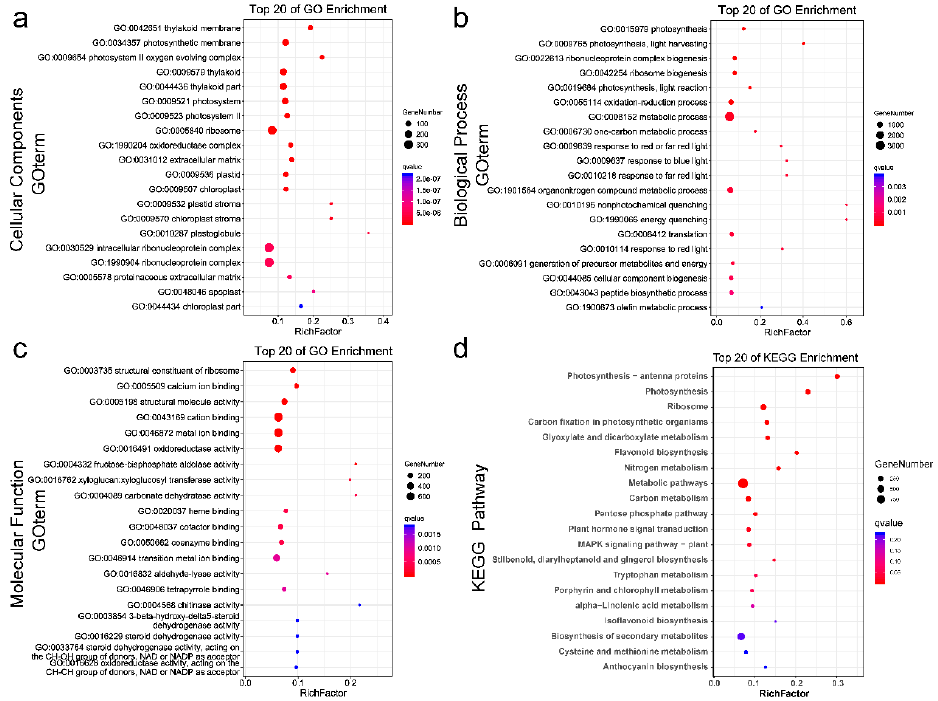
Figure 4. GO annotation and KEGG pathway analysis. ( a – c ) Top 20 GO enrichment classifications of DEGs in ( a ) cellular components, ( b ) biological process, and ( c ) molecular function; ( d ) top 20 KEGG enrichment pathways of DEGs. The y-axis represents the top enriched GO or KEGG pathways’ terms. The size and color of circles indicate the number of genes and Q-values of the enriched term, respectively. The x-axis represents the rich factor (RF), which refers to the ratio between the number of DEGs and the number of genes annotated in a given term or pathway. A large RF indicates a high degree of enrichment.